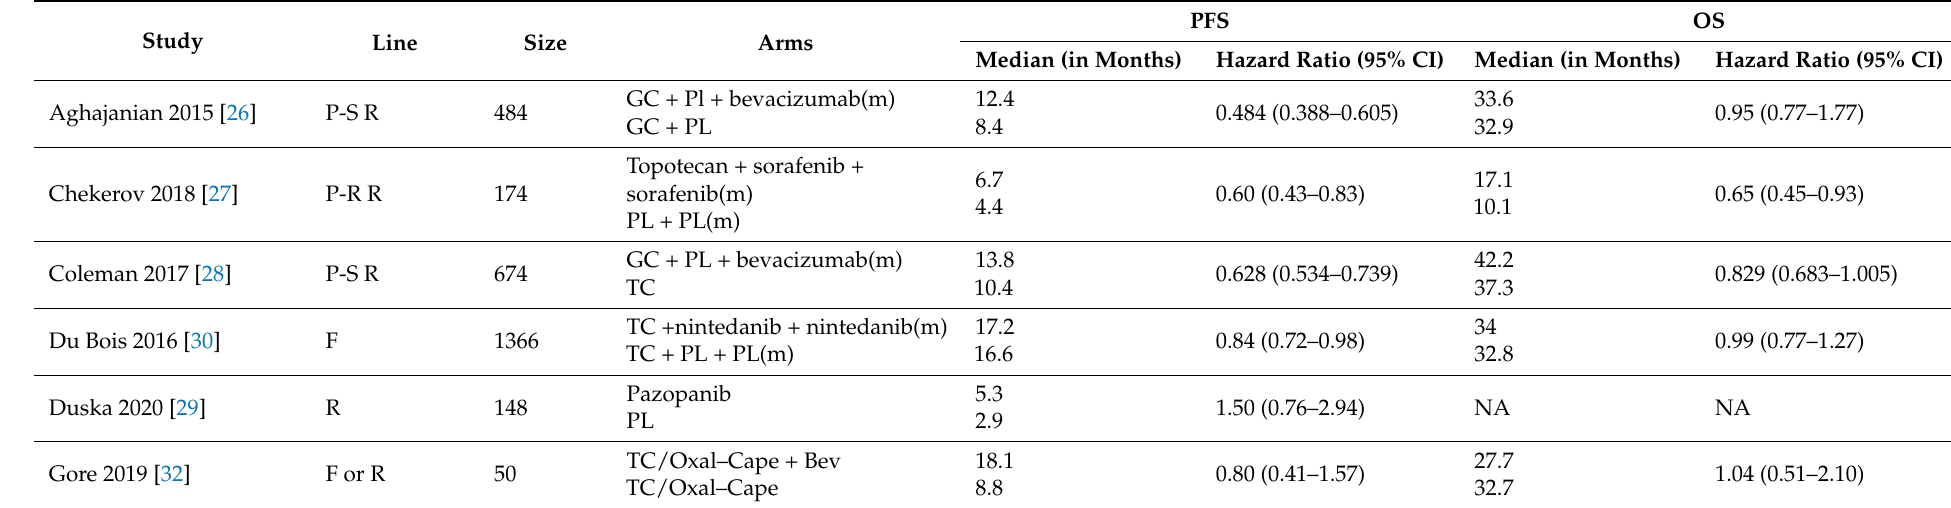
Table 3. Summary of outcomes of included